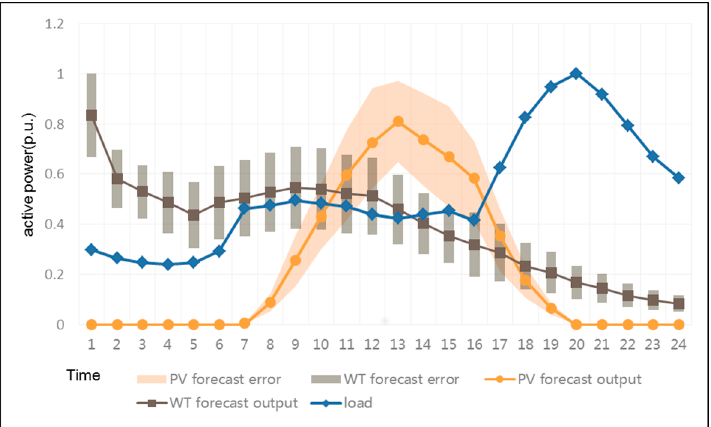
Figure 4. IEEE 33 nodes distribution system integrated DERs.